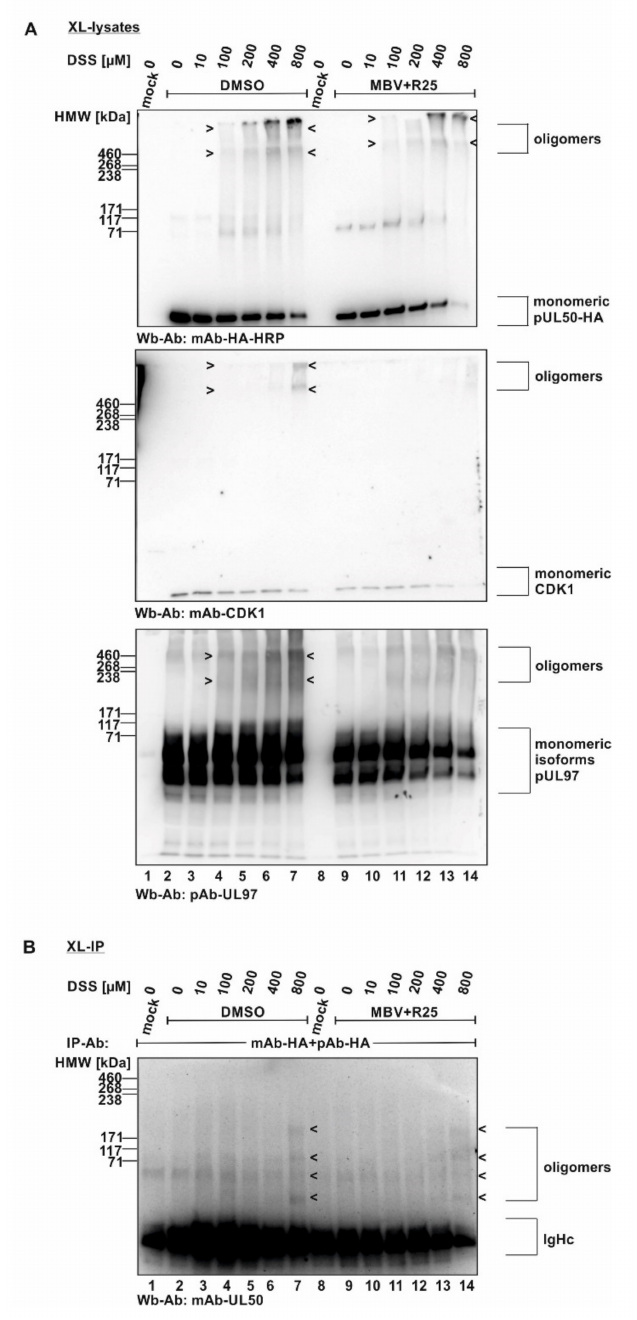
Figure 6. Inhibitory effect of kinase inhibitors on the association of CDK1 with oligomeric HCMV core NEC. ( A ) Proteins derived from total cellular lysates. ( B ) Proteins derived from coimmunoprecipitates. HFFs were seeded in 6-well plates, used for HCMV AD169 UL50-HA infection at an MOI of 1.5 and treated with the mixture of R25 and MBV at 3 d p.i. Cells were harvested at 5 d p.i. and cross-link was performed by addition of different concentrations of DSS. Core NEC oligomers and their associated protein kinases could be illustrated by Wb analysis. Different order of core NEC oligomers could be demonstrated by coimmunoprecipitation and Wb detection using the respective tag-specific